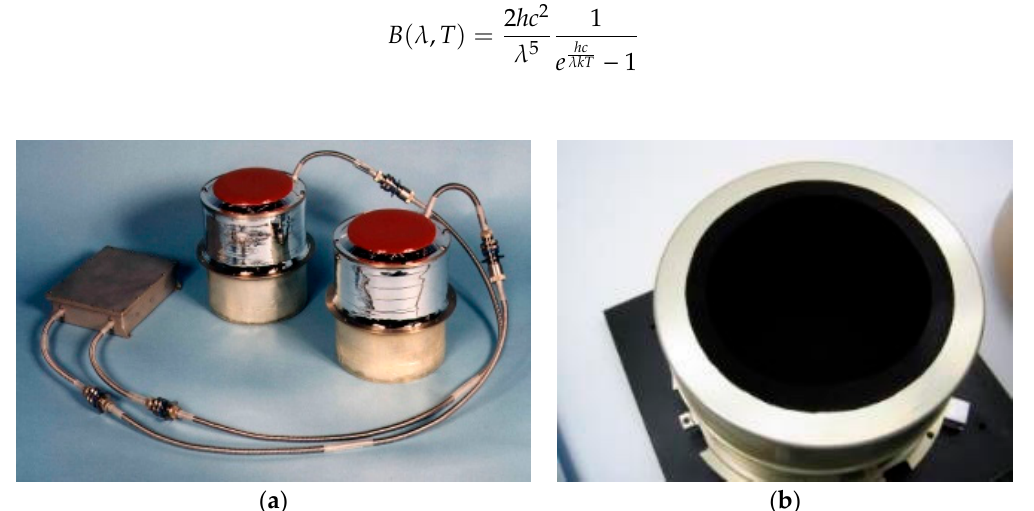
Figure 1. Flight blackbody calibration sources for the Advanced ATSR (AATSR) ( a ) and SLSTR ( b ).